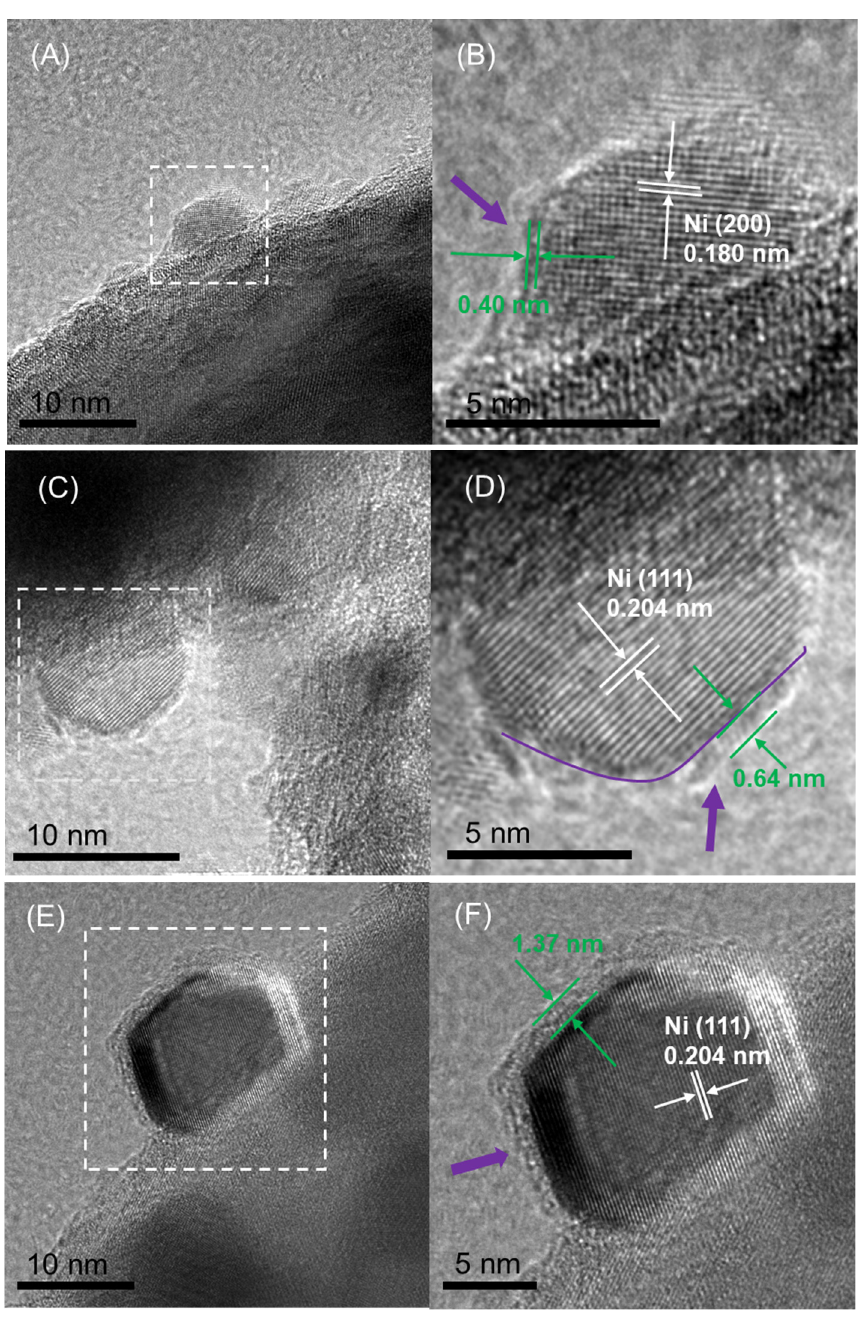
Figure 4. HR-TEM images of 650 °C-reduced ( A – B ) 1Ni/r-TiO 2 , ( C – D ) 5Ni/r-TiO 2 , and ( E – F ) 10Ni/r- TiO 2 . The white line indicates the lattice stripes of Ni(111) and Ni(200), and the purple arrow highlights the TiO x overlayer and marks its thickness with a green line.